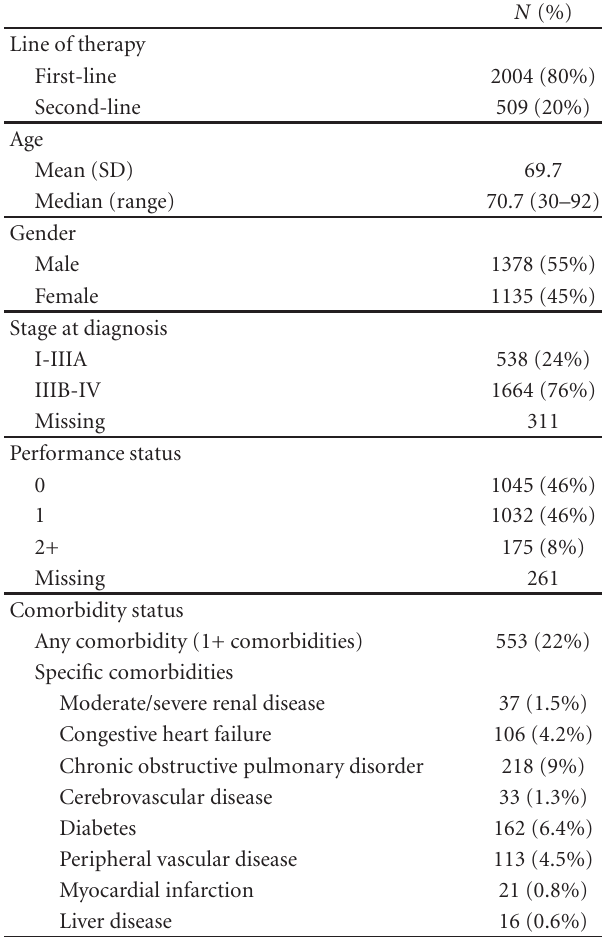
Table 1: Patient characteristics of study sample ( N =